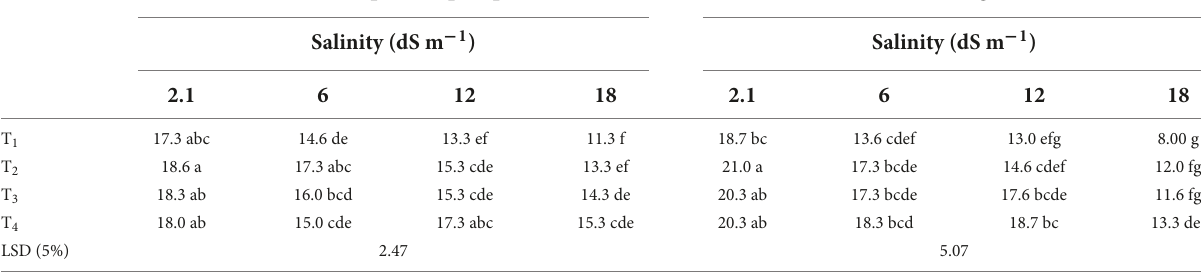
TABLE 4 Effect of inoculation with multi-strain bacterial consortium on a number of spikelets per spike of wheat at different salinity levels in a pot trial. Strain